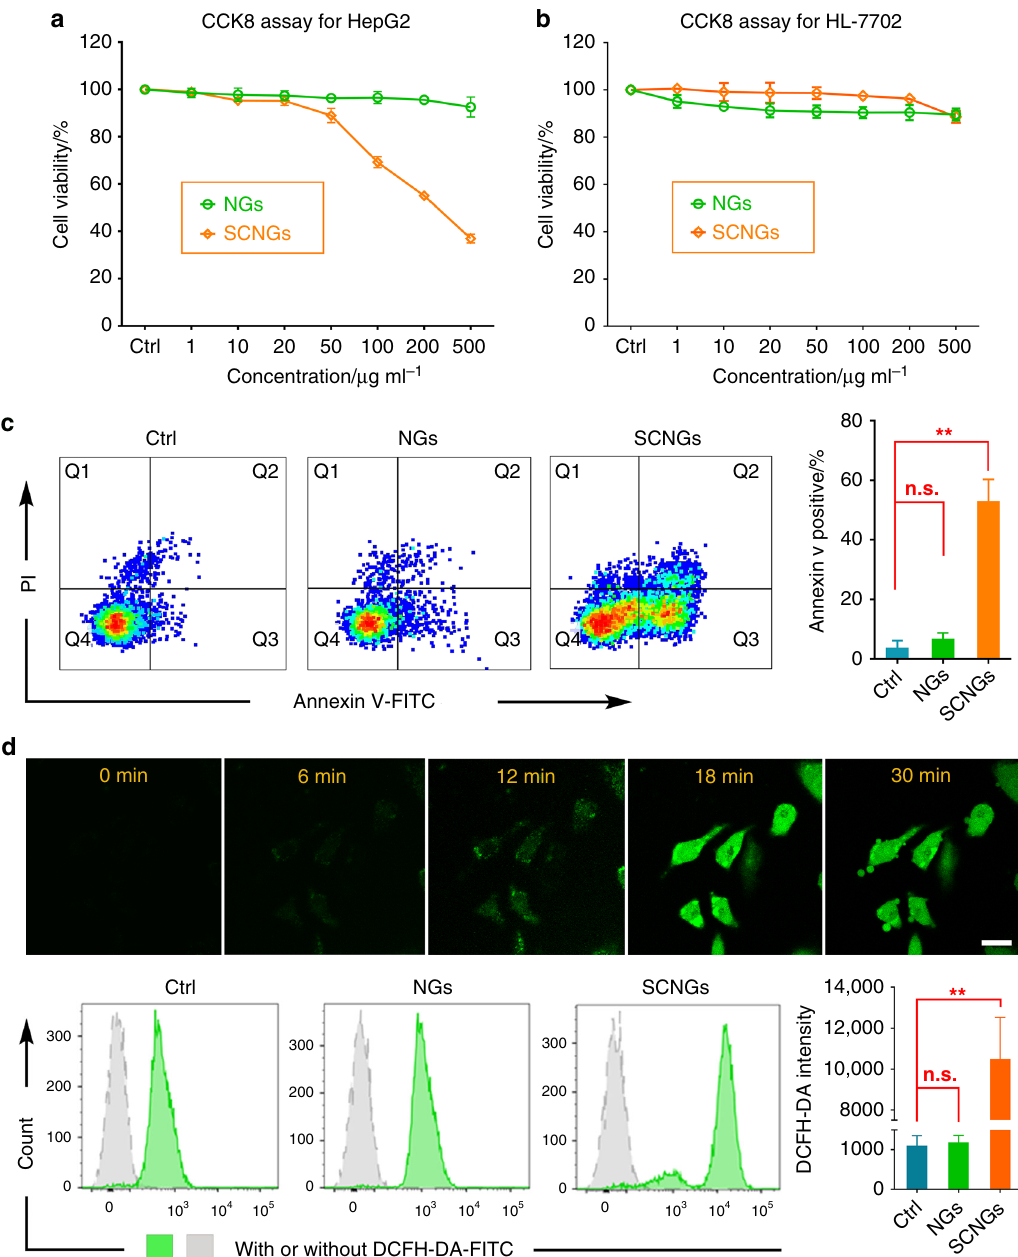
Fig. 4 Safety, ef fi ciency and mechanism of EDT. a Cytotoxicity of NGs and SCNGs by CCK8 assays after incubated with HepG2 cells for 24 h with the concentration of 1 μ g mL -1 to 500 μ g mL -1 . NGs exhibited no signi fi cant effect on the cell survival, while SCNGs had increased cytotoxicity to HepG2 cells with the increase of concentration. Data are presented as mean ± s.d. ( n = 3). b Cytotoxicity of NGs and SCNGs by CCK8 assays after incubated with